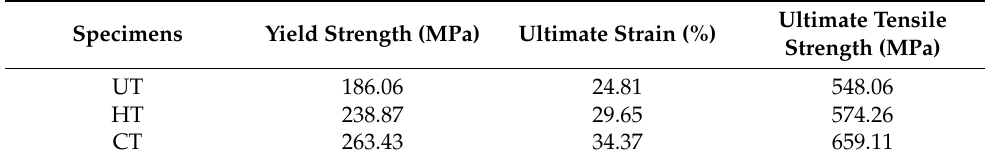
Figure 6. Engineering stress strain graph for HT, CT, and UT specimens. Table 4. Experimental results of tensile testing.